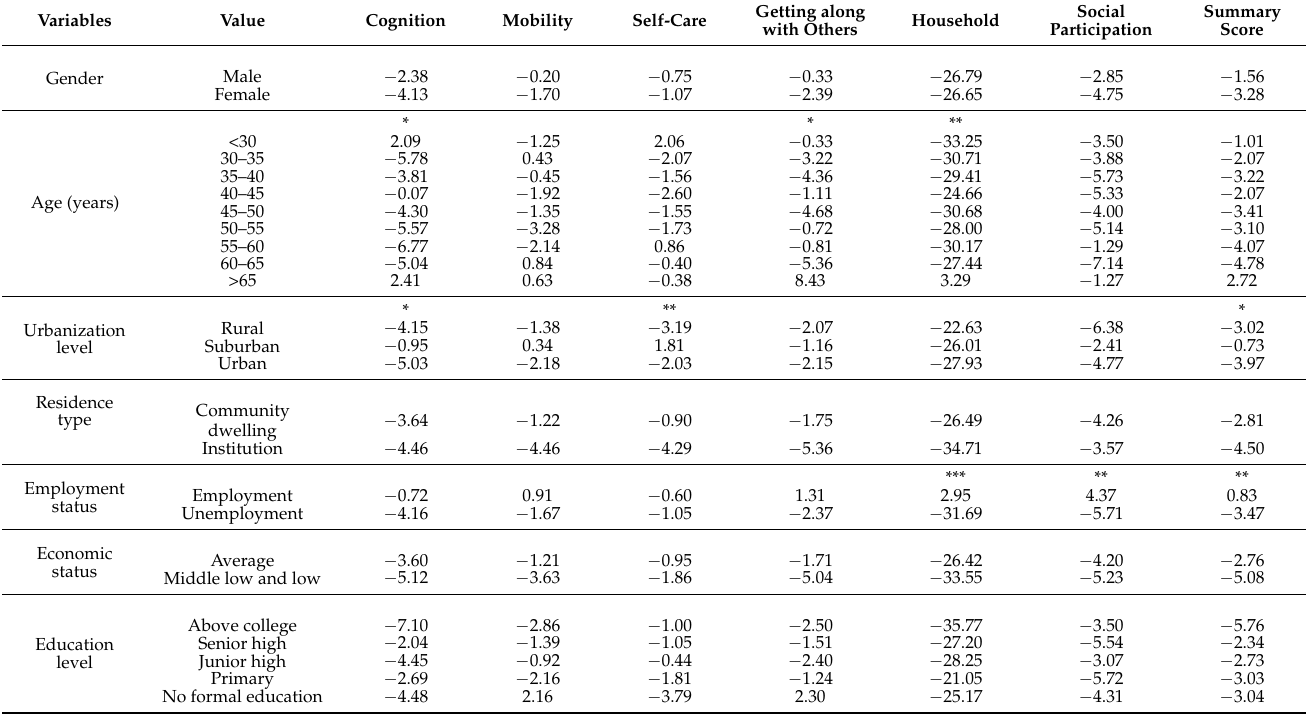
Table 3. The two years difference in score on the WHODAS2.0 (T2-T1 or T3-T2 or T3-T1) according to different variables (mean, n =